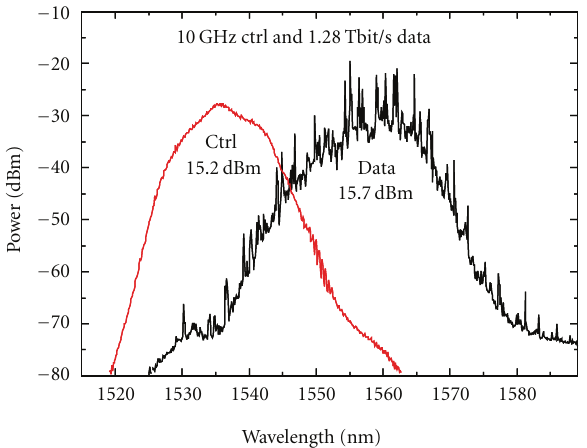
Figure 5: Spectral overlap of control and data pulses in the